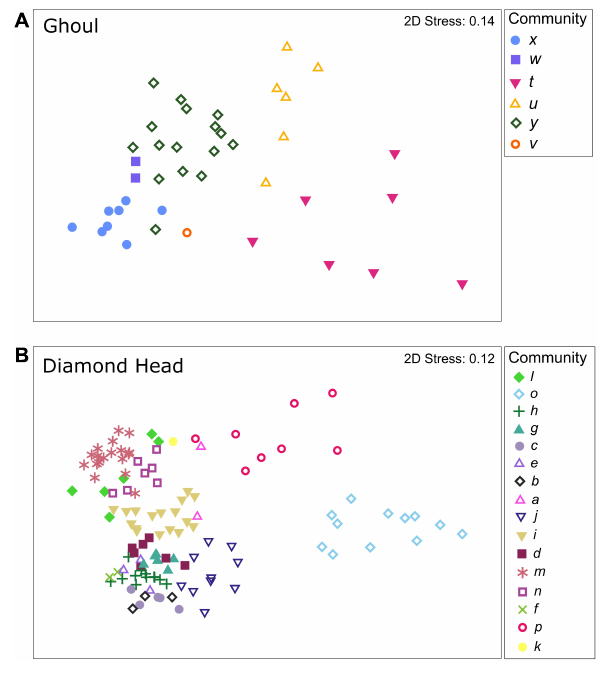
FIGURE 2 | Non-metric multidimensional scaling (nMDS) plots showing variation in sample dissimilarities between and within mega-epibenthic communities identified on the seamounts (A) Ghoul and (B) Diamond Head. Stress values below 0.2 indicate adequate 2D